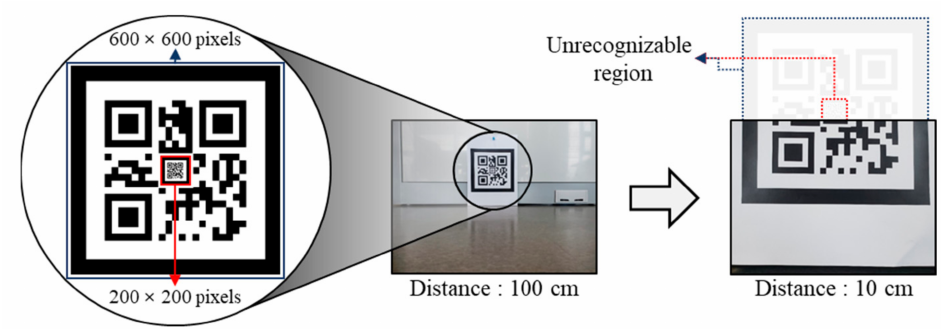
Figure 6. Problem in using nested marker with mobile